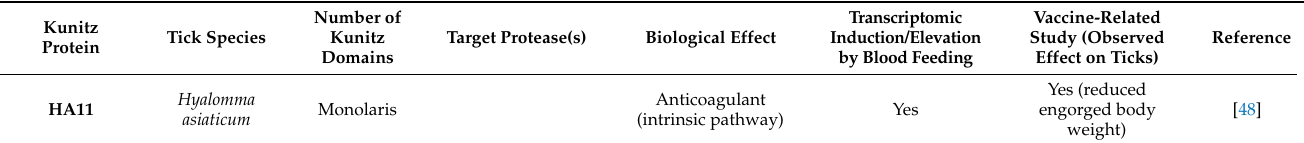
Table 1. Kunitz-type inhibitors characterized in tick